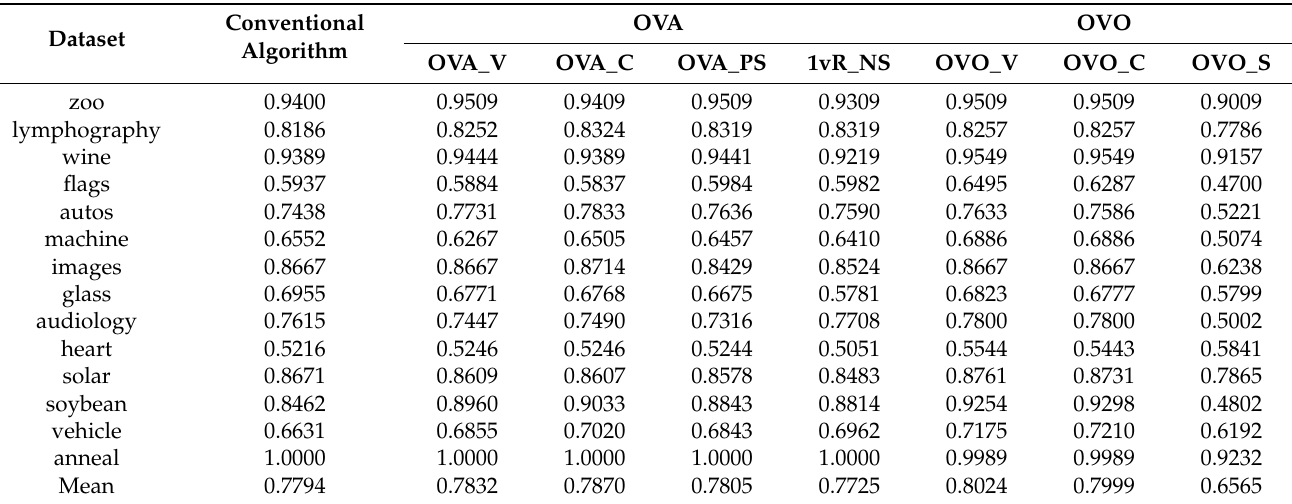
Table 3. Classification accuracy of OVA and OVO approach.